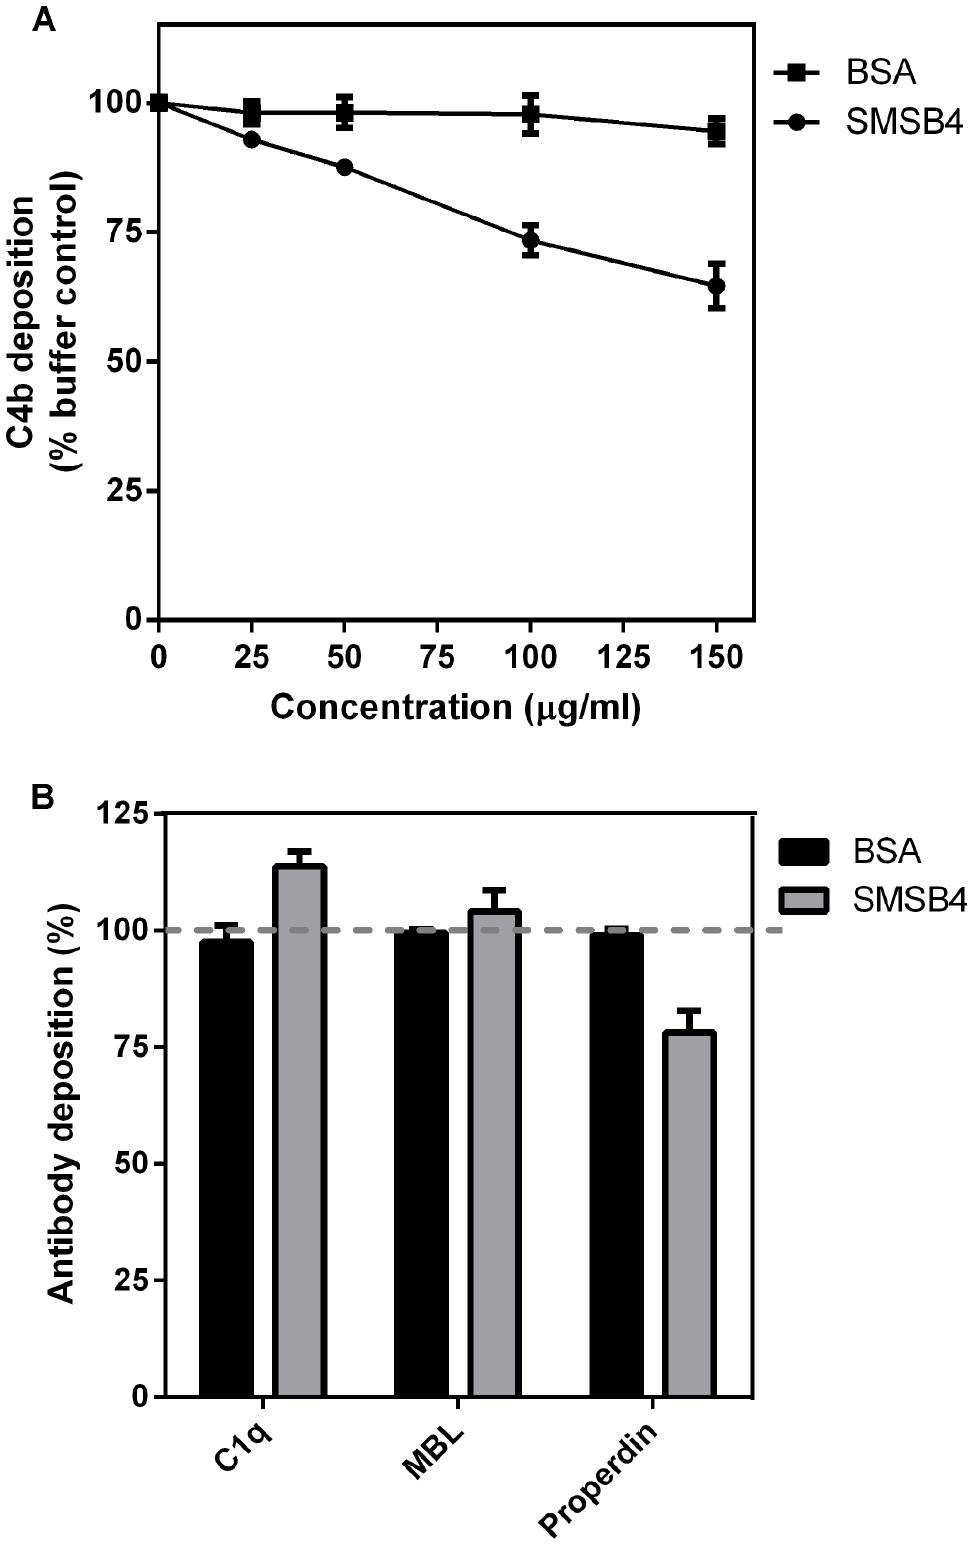
Figure 4. Effect of SMSB4 on the depositions of C4b ( A ), C1q, MBL and properdin ( B ) on S.aureus cells . The wells of 96-well microtiter plates were coated with 100 m l aliquots of bacterial cell suspensions containing 5 6 10 6 cfu/ml of S. aureus . Wells were then incubated with 10% NHS which has been pre-treated with increasing concentrations of either SMSB4 or BSA. Antibodies were detected by ELISA using primary human specific antibodies, followed by HRP-conjugated secondary antibodies, and fluorescence was detected at 490 nm. Results are shown as means 6 SEM from